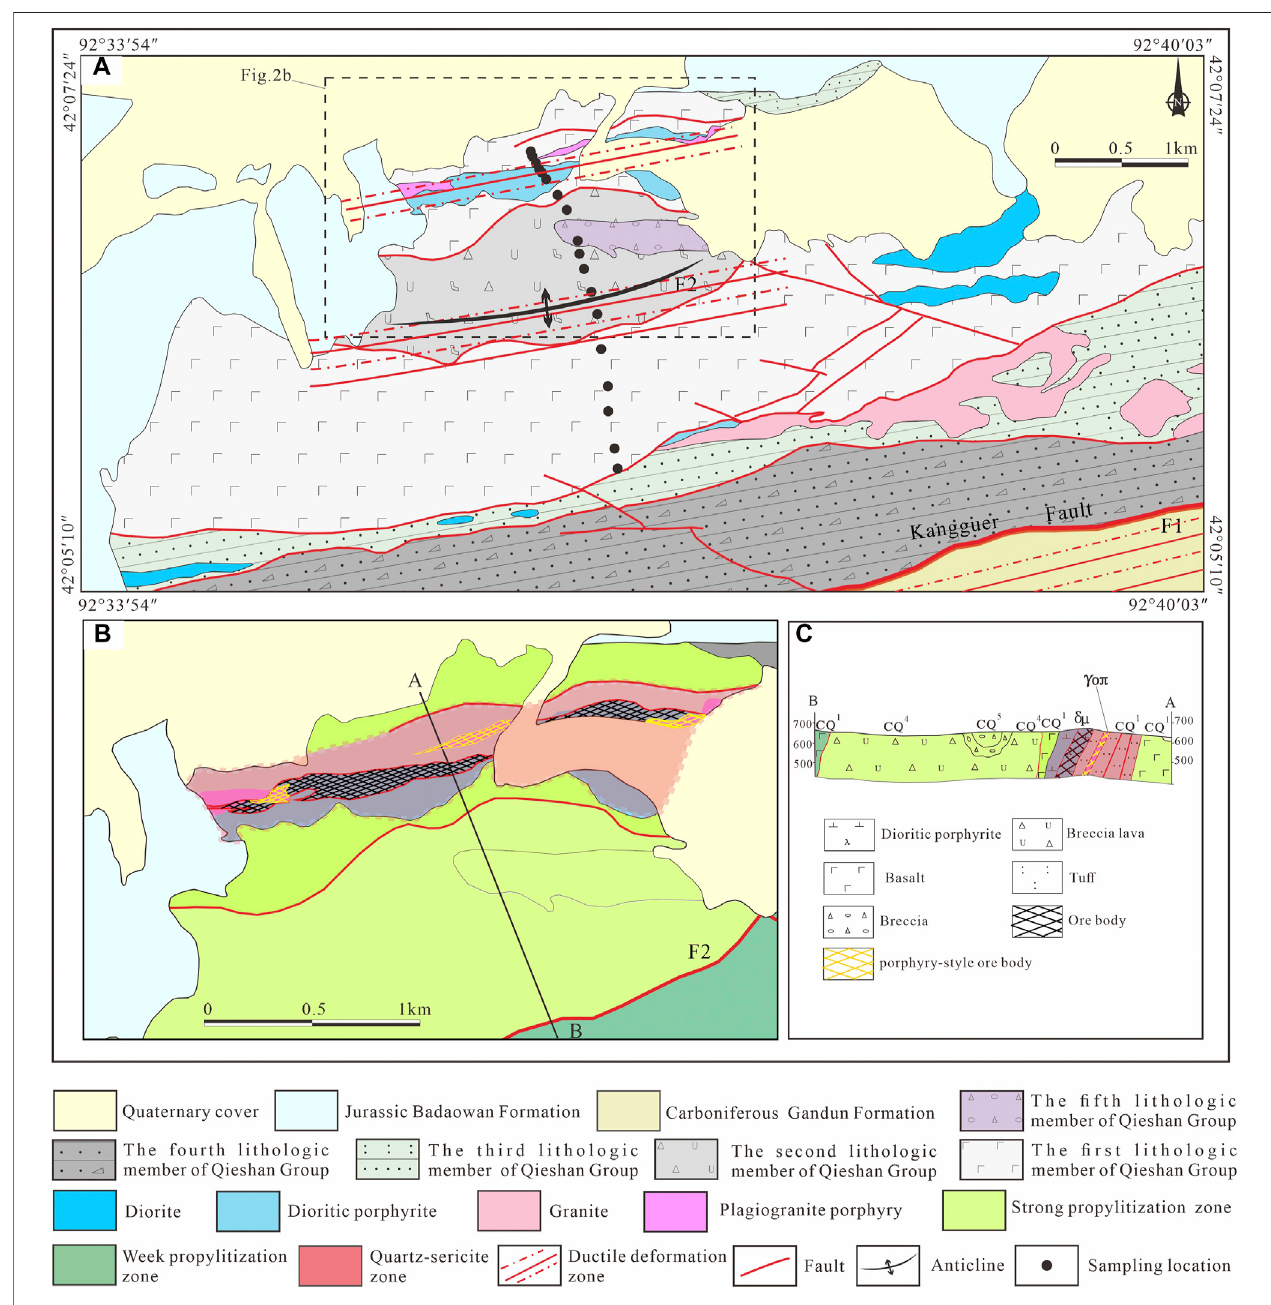
FIGURE 2 | (A) Geological map of the porphyry Cu deposit in eastern Tianshan, Xinjiang, NW China (revision according to Ma et al., 2003; Pan et al., 2013). (B) Alteration zonation map of the Tuwu copper ore district. (C) Pro fi le map of the Tuwu copper ore district.